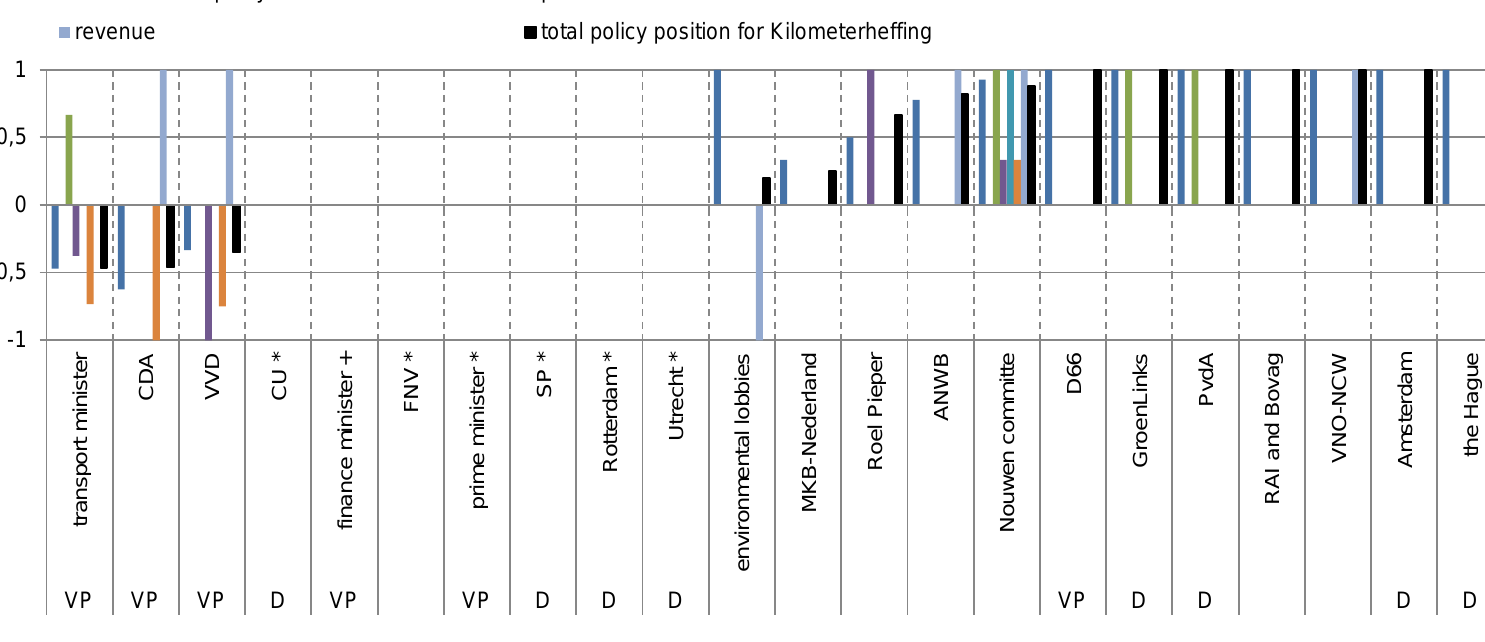
Figure 4. Pro- and anti- Kilometerheffing advocacy coalitions in government period 4 (2003 -